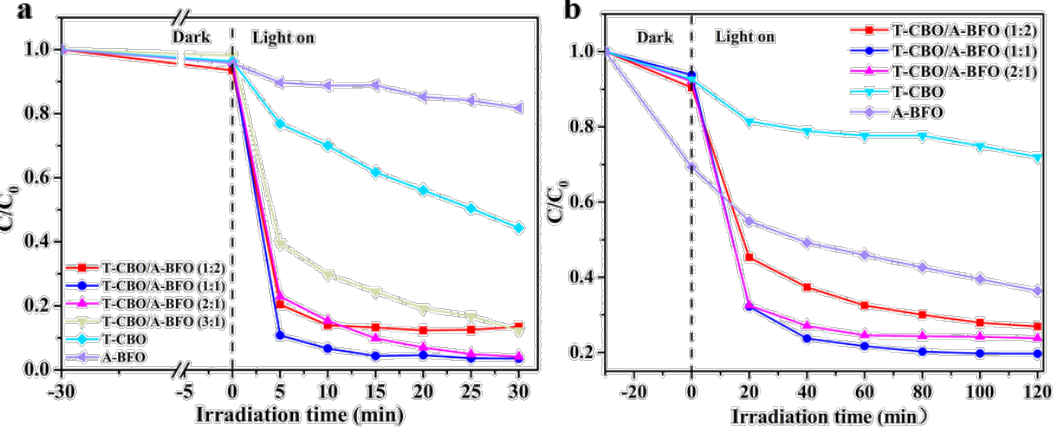
Figure 8. photocatalytic degradation of ( a ) methylene blue; ( b ) methyl orange. C 0 is the concentration of the initial dye solution, C t is the remaining concentration of dye solution at a reaction time of t, C t /C 0 is the residual ratio of the dye in the solution, the degradation rate equals 1 − C t /C 0 .